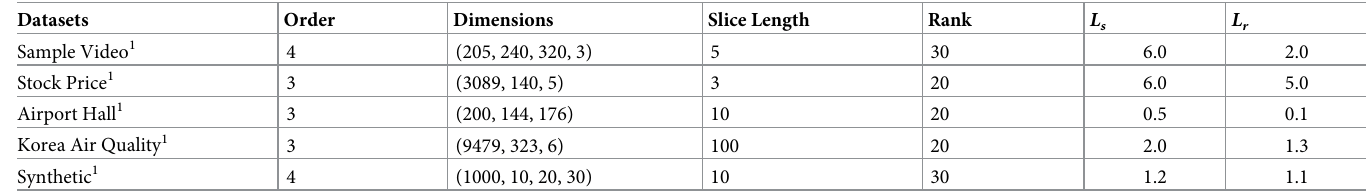
Table 4. Summary of